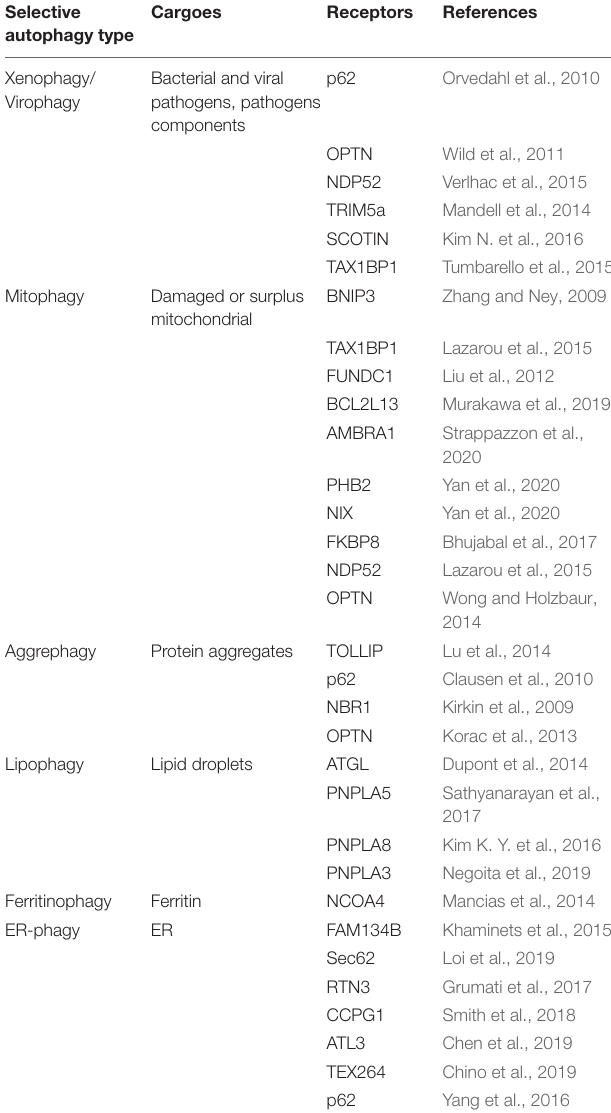
TABLE 1 | Selective autophagy cargoes and